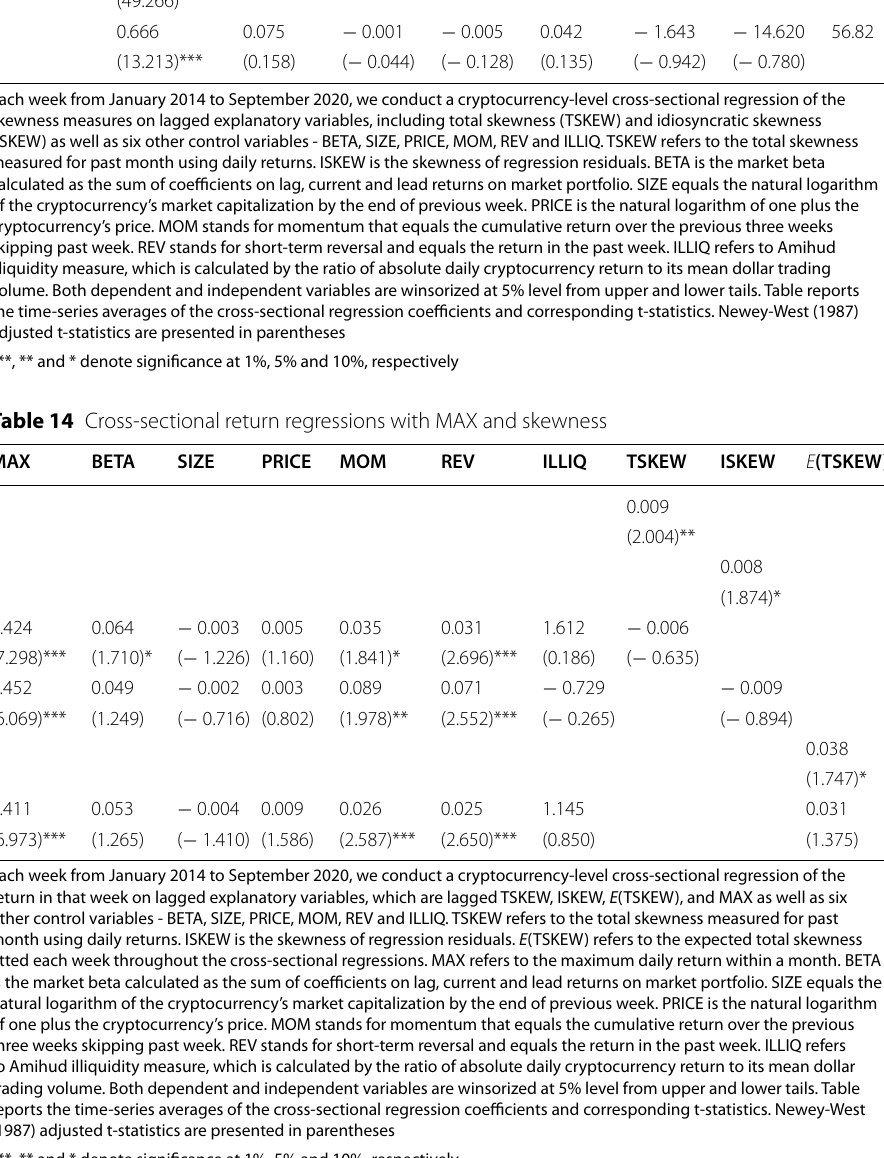
Each week from January 2014 to September 2020, we conduct a cryptocurrency‑level cross‑sectional regression of the skewness measures on lagged explanatory variables, including total skewness (TSKEW) and idiosyncratic skewness (ISKEW) as well as six other control variables ‑ BETA, SIZE, PRICE, MOM, REV and ILLIQ. TSKEW refers to the total skewness measured for past month using daily returns. ISKEW is the skewness of regression residuals. BETA is the market beta calculated as the sum of coefficients on lag, current and lead returns on market portfolio. SIZE equals the natural logarithm of the cryptocurrency’s market capitalization by the end of previous week. PRICE is the natural logarithm of one plus the